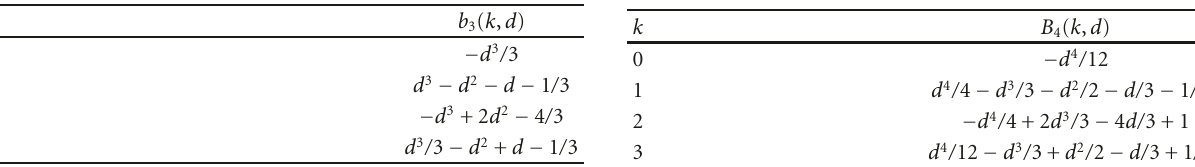
Table 1: Filter coe ffi cients for the third-order B-spline bandlimited impulse train (BLIT)synthesiser asa function of the fractional delay d .